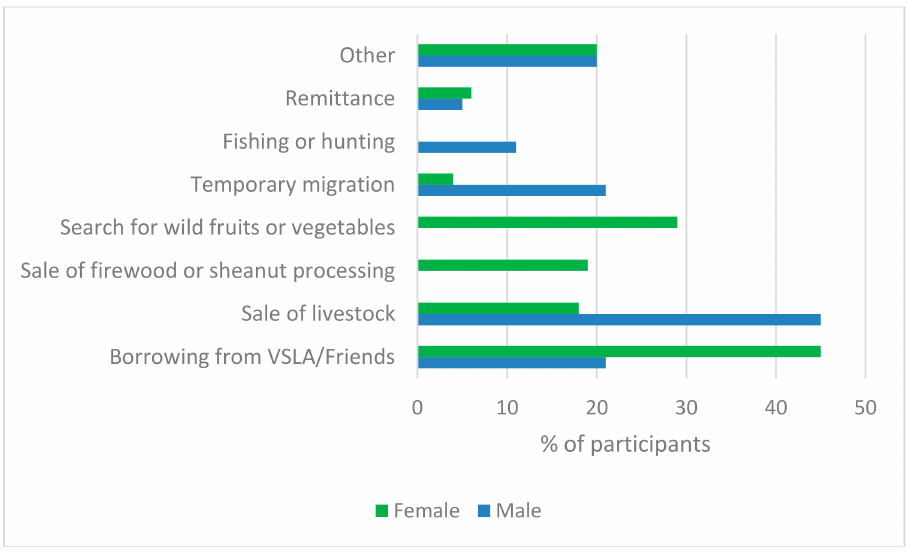
Figure 2. Measures for coping with adverse climate impacts by